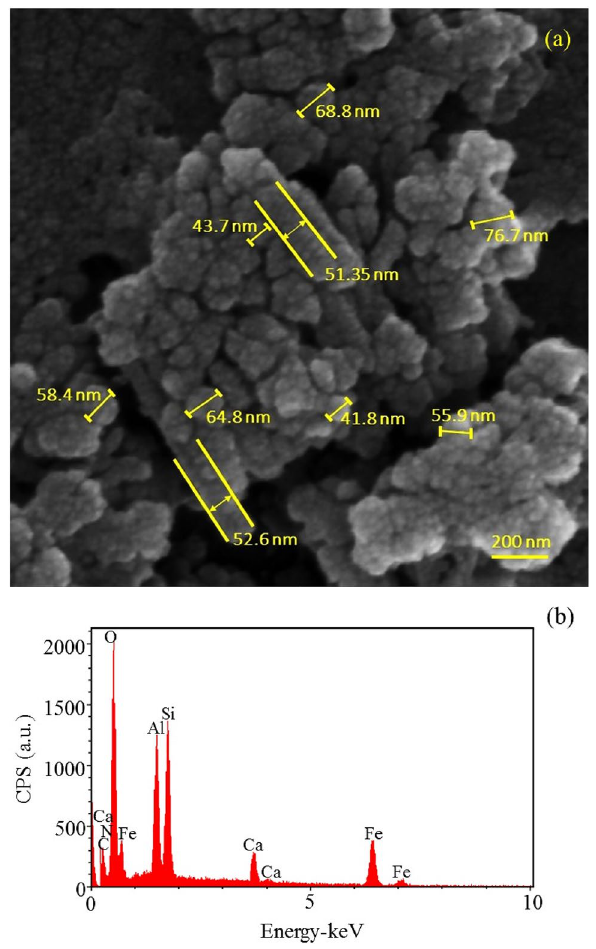
Figure 2. ( a ) The FE-SEM image and ( b ) EDX spectrum of SA/SF/HNTs/Fe 3 O 4